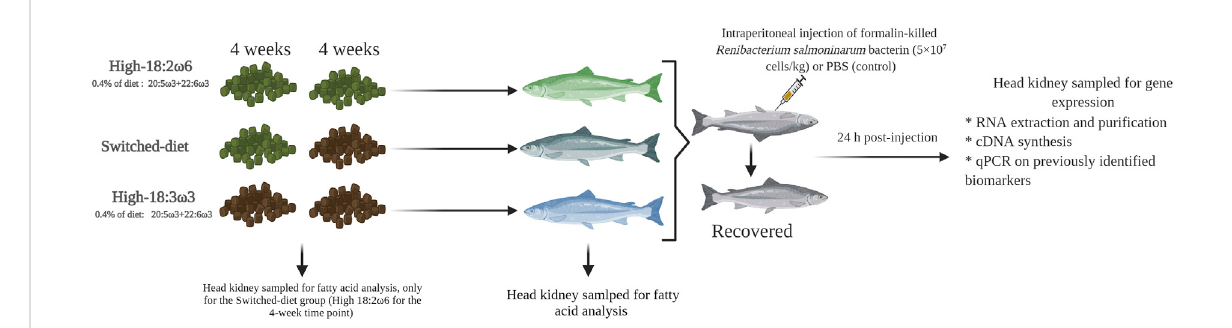
FIGURE 1 Experimental design showing sampling time points for fatty acid and qPCR analysis. This fi gure was constructed using